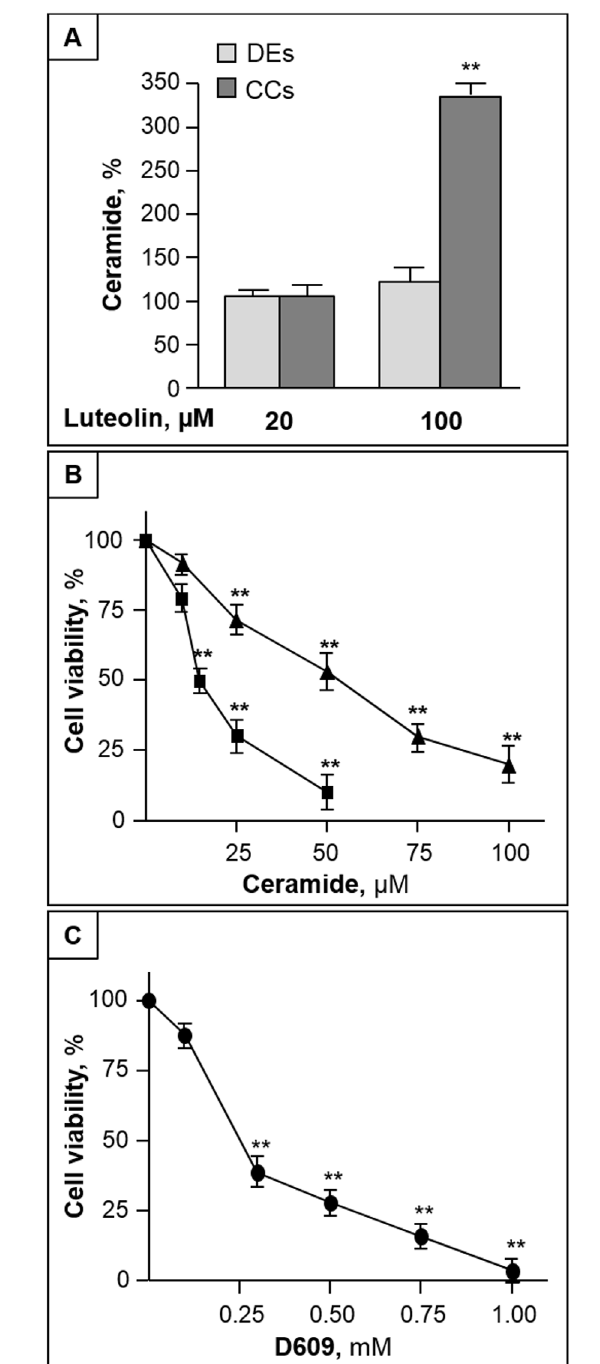
Fig 2. Luteolin increases ceramide level in CC cells, and induced elevation of ceramide leads to CC cell toxicity. (A) DEs and CC cells were treated with luteolin, and, after 24 h, cellular ceramide was quantified. (B) and (C) CC cells were treated with different concentrations of C2-Cer (B, square), C6-Cer (B, triangle) or D609 (C), and after 48 h cell viability was assessed by MTT. All data are the mean ± S.D. of three independent experiments. * , p < 0.05; ** , p < 0.01 vs